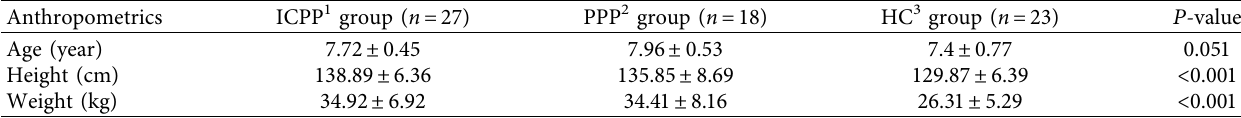
Table 1: Te comparison of the general information of the children in the three groups.